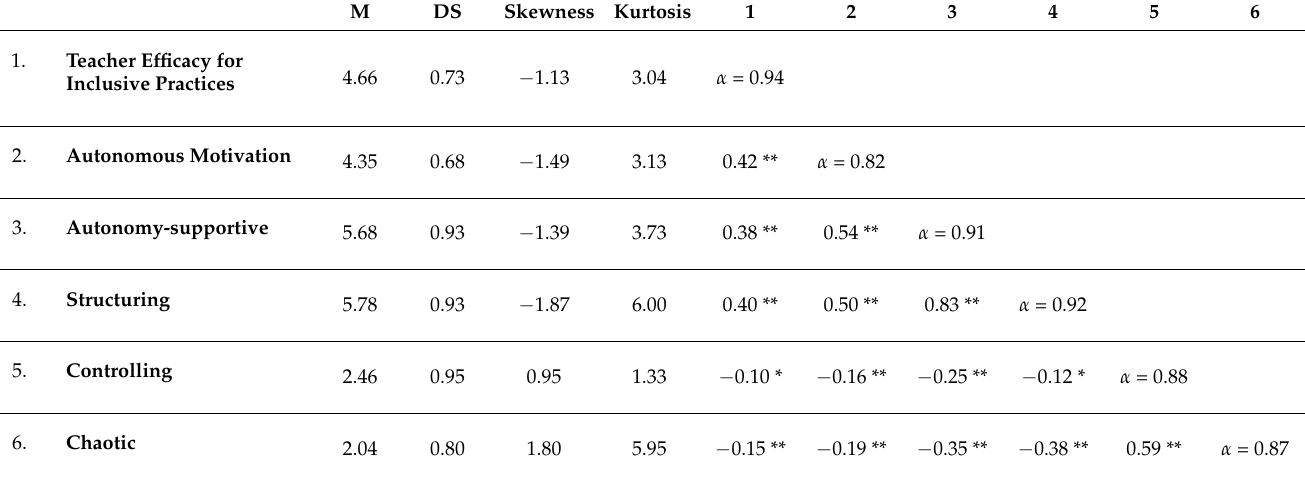
Table 1. Descriptive statistics and correlational